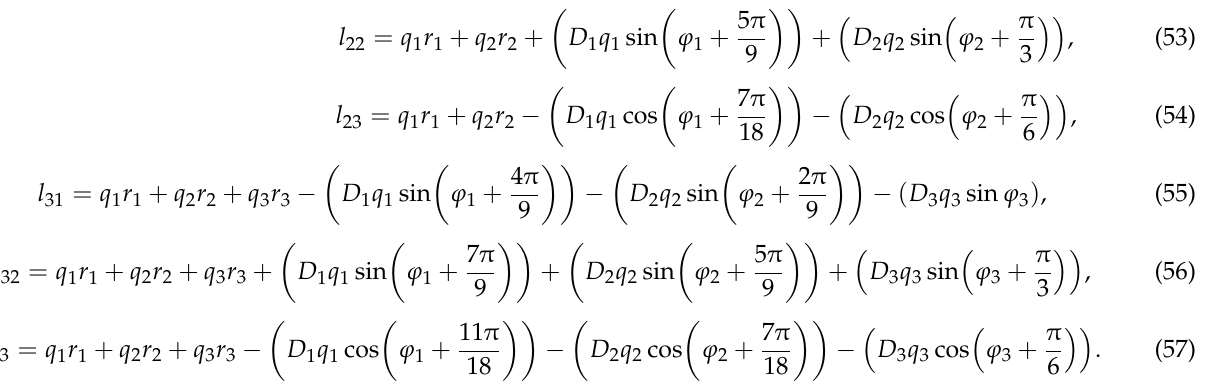
Table 2. Robot orientations and position errors as in the simulations in Figures 18 ‒ 21.